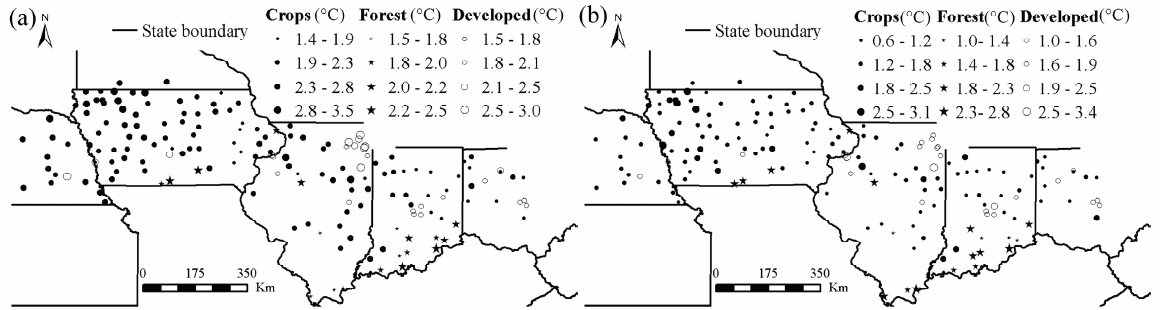
Figure 4. Spatial distribution of Tmax ( a ) and Tmin ( b ) (°C) estimation accuracy (RMSE) for all the meteorological